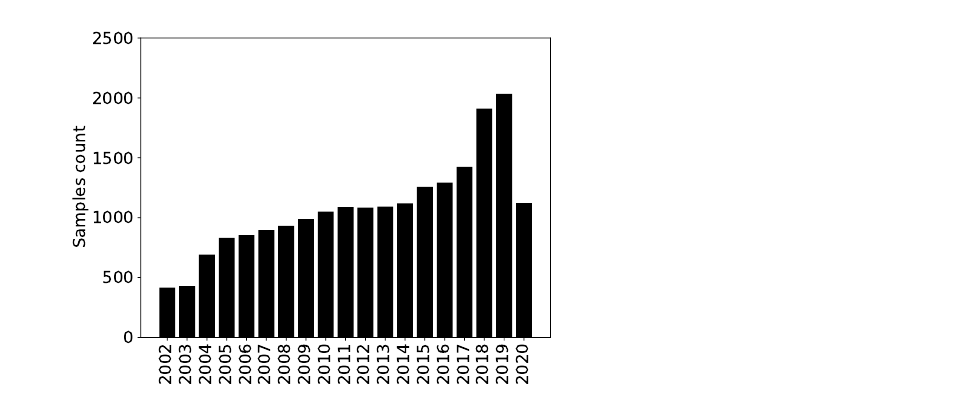
Figure 3. Time evolution of the number of samples per year in the Refinitiv ESG dataset—Europe.